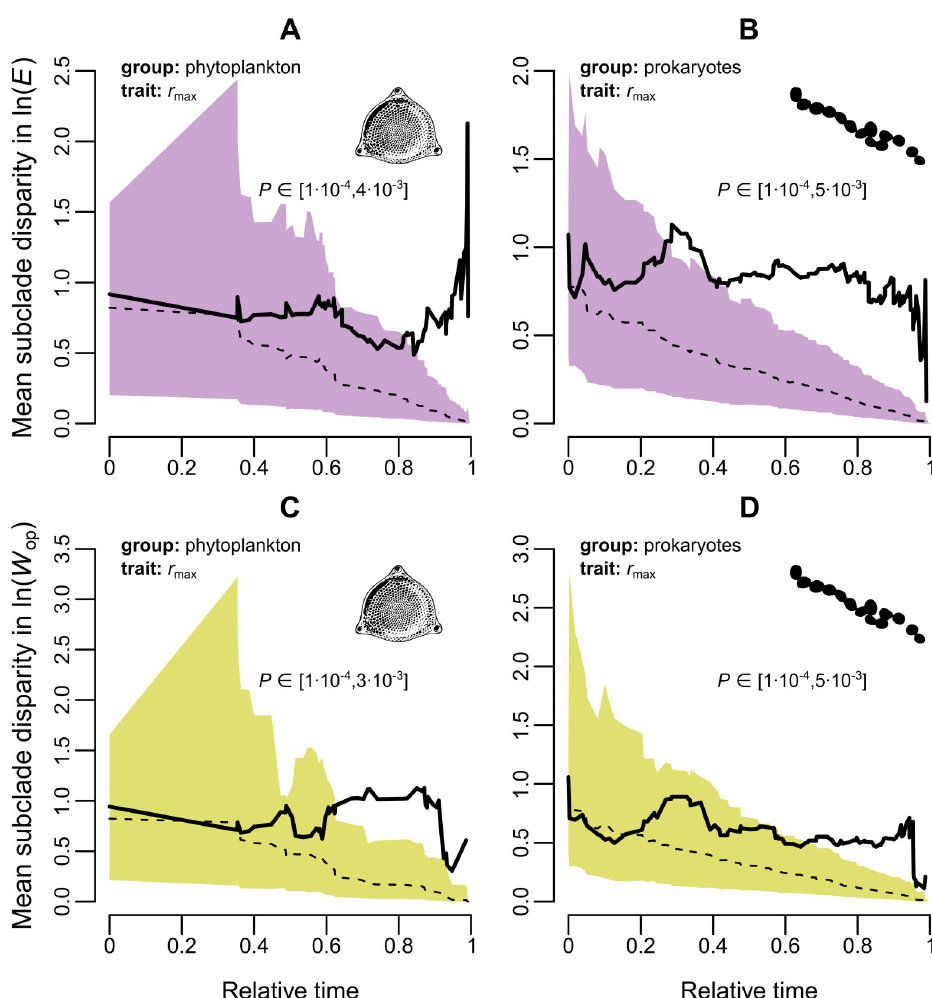
Fig 3. Change in mean subclade disparity in thermal sensitivity through time. Shaded regions represent the 95% confidence interval of the resulting trait disparity from 10,000 simulations of random Brownian evolution on each respective subtree (subset of the entire phylogeny). The dashed line stands for the median disparity across simulations, whereas the solid line is the observed trait disparity. The latter is plotted from the root of the tree ( t = 0) until the most recent internal node. The reported P values were obtained from the rank envelope test [40], whose null hypothesis is that the trait follows a random walk in the parameter space. Note that instead of a single value, a range of P values is produced for each panel, due to the existence of ties. In general, species from evolutionarily remote clades tend to increasingly overlap in thermal sensitivity space (mean subclade disparity exceeds that expected under Brownian motion) with time. The raw data underlying this figure are available at https://doi.org/10.6084/m9.figshare.12816140. v1.